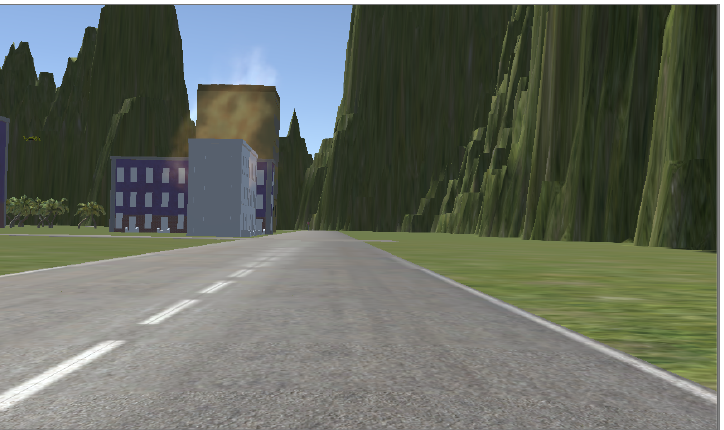
Figure 17. The third obstacle with a fire